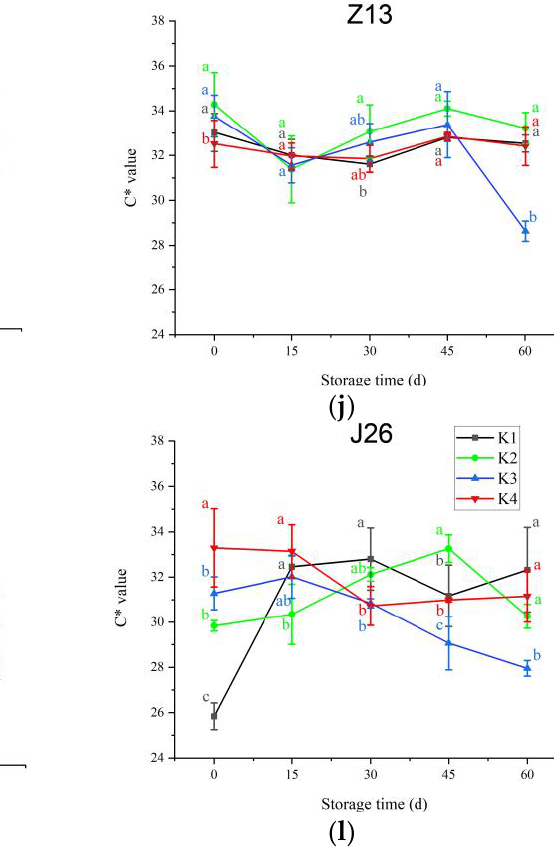
Figure 5. Flesh color of the tuberous root of different UCZ treatments during storage. ( a ) L* value of Z13; ( b ) L* value of Z33; ( c ) L* value of J26; ( d ) a* value of Z13; ( e ) a* value of Z33; ( f ) a* value of J26; ( g ) b* value of Z13; ( h ) b* value of Z33; ( i ) b* value of J26; ( j ) C* value of Z13; ( k ) C* value of Z33; ( l ) C* value of J26. Values within the same storage day of the same year followed by the same letter are not significantly different at the 5% level according to ANOVA-Duncan’s multiple range test. K1: Normal basal fertilizing without UCZ; K2: Normal basal fertilizing with UCZ; K3: Rich basal fertilizing without UCZ; K4: Rich basal fertilizing with